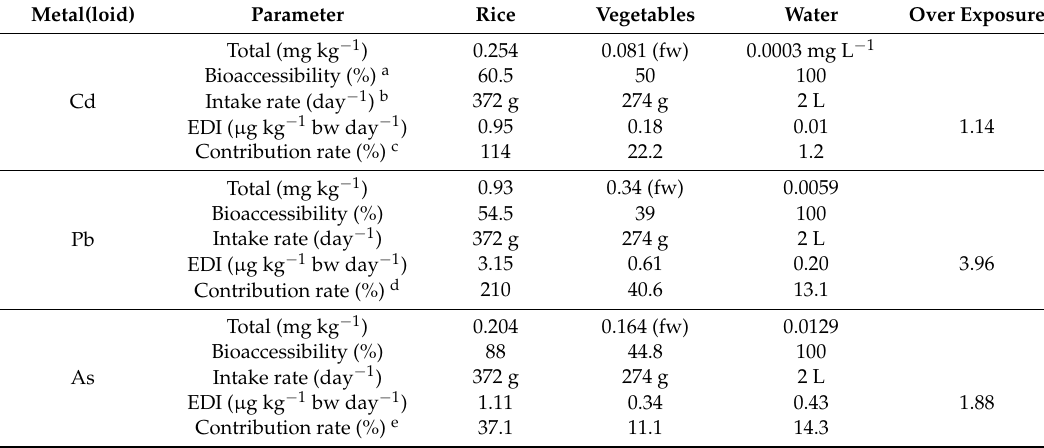
Table 1. Calculated values of established diary intake (EDI) and contribution rate (%) for Cd, Pb and As based on the gastrointestinal metal(loid)s bioaccessibility data via consumption of rice, vegetables, drinking water for an adult with body weight of 60